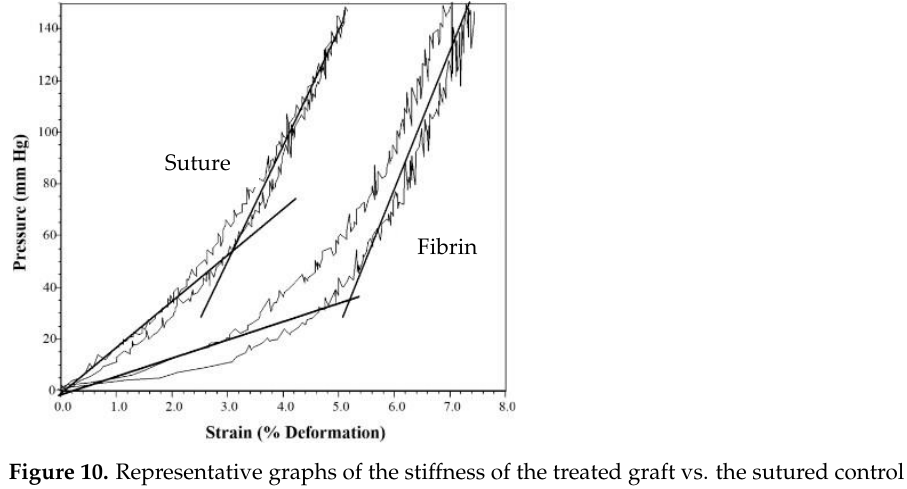
Figure 9. The average perfusion data for the clinical burn patients. The two fibrin treatments are scored relative to the sutured control [56].